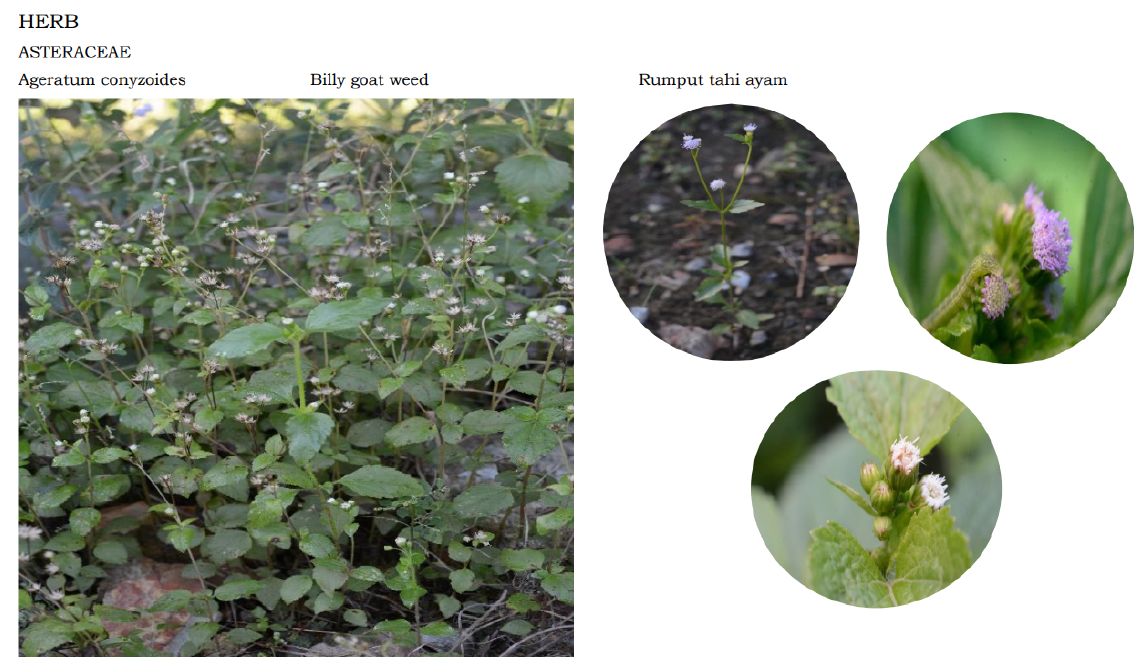
Figure A1 . Herb Asteraceae: Ageratum conyzoides. Figure A1. Herb Asteraceae: Ageratum conyzoides